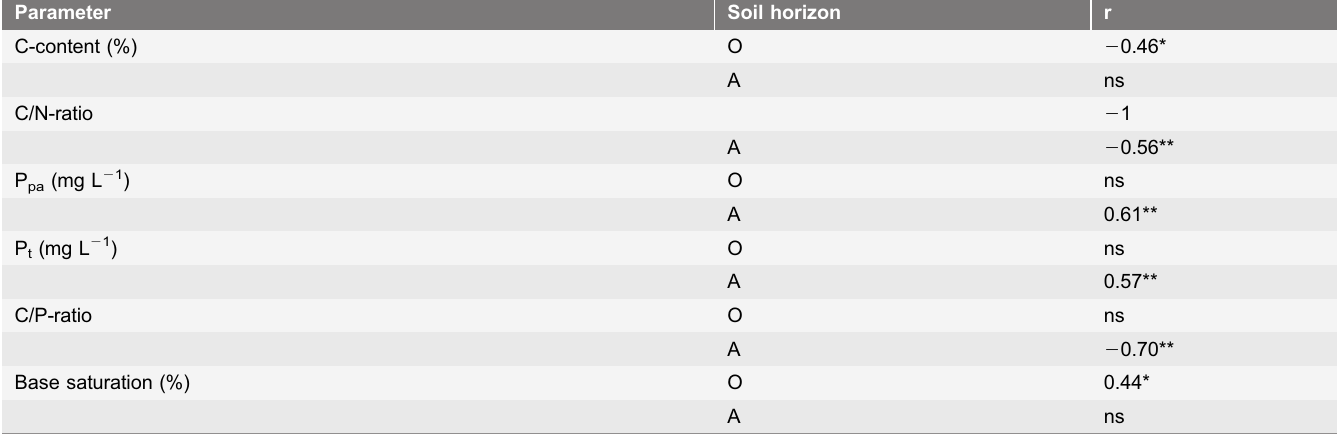
Table 3. Pearson’s correlations between mean tree-ring widths (of sample sites; n 5 21) and soil